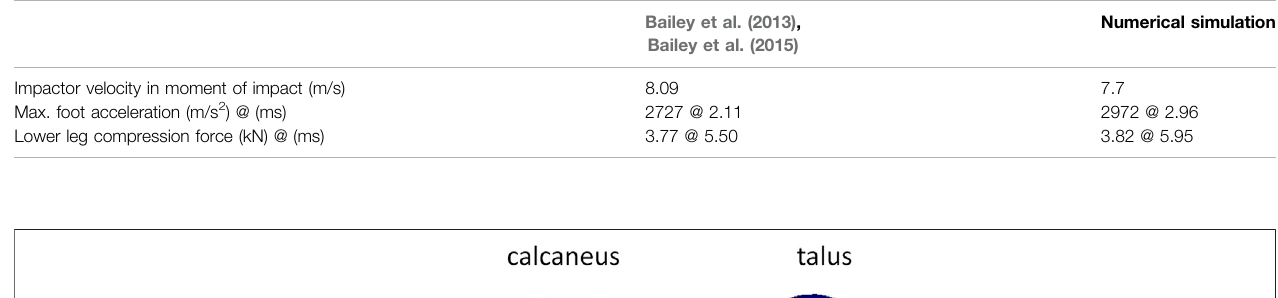
TABLE 4 | Obtained results: peak stress values of bones and forces in ankle joint.